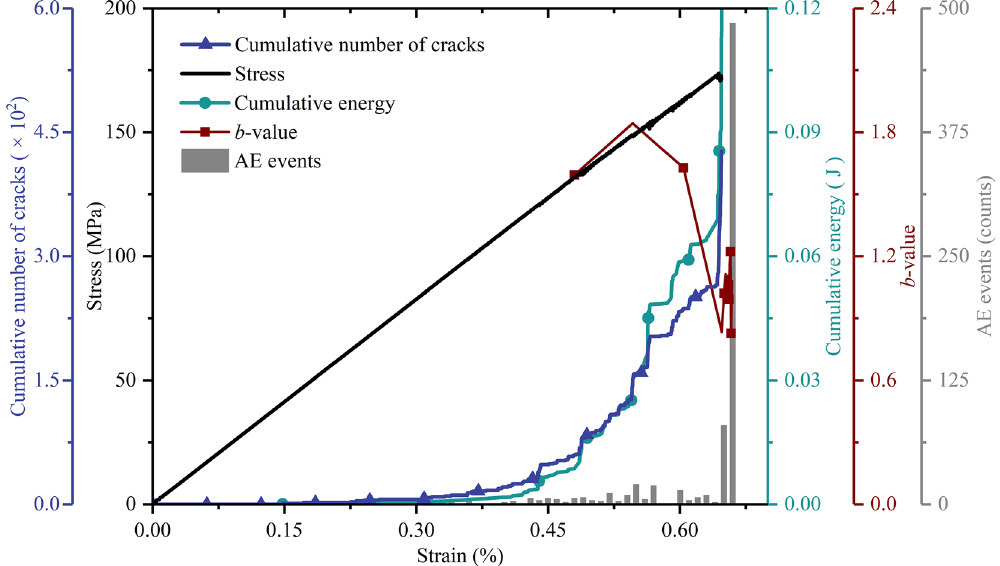
Figure 5. Axial stress, cumulative number of cracks and simulated AE parameters (cumulative energy, b -value and AE events) versus axial strain by